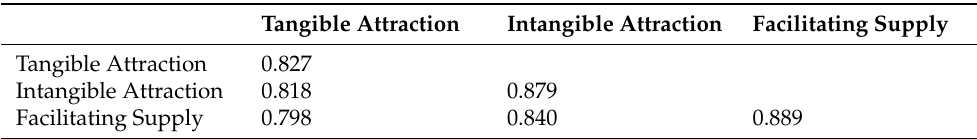
Table 4. Discriminant validity: Pearson correlation coefficient and squared root of average variance extracted (AVE) for cognition.